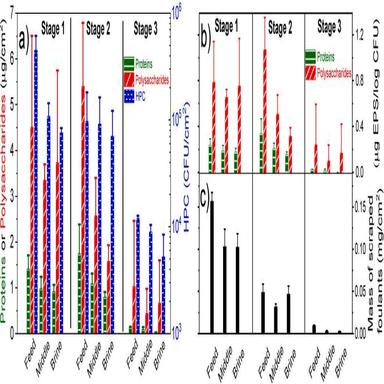
(a) Areal concentrations of proteins (green) and polysaccharides (red) in the left y-axis, and HPC (blue) in the right y-axis. (b) Loosely bound EPS normalized by HPC. (c) Dry mass of foulants scraped per unit area of the membrane surface. Results from each of the three stages are shown. (For interpretation of the references to color in this figure legend, the reader is referred to the Web version of this article.)